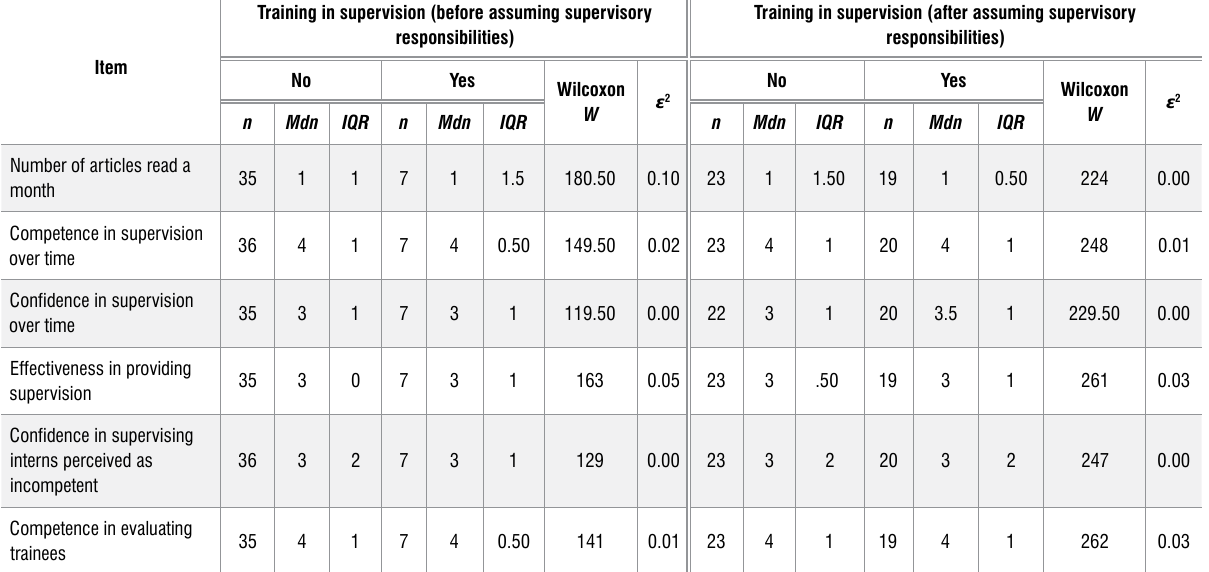
Summary statistics for Wilcoxon rank-sum tests on training in supervision Training in supervision (before assuming supervisory Item